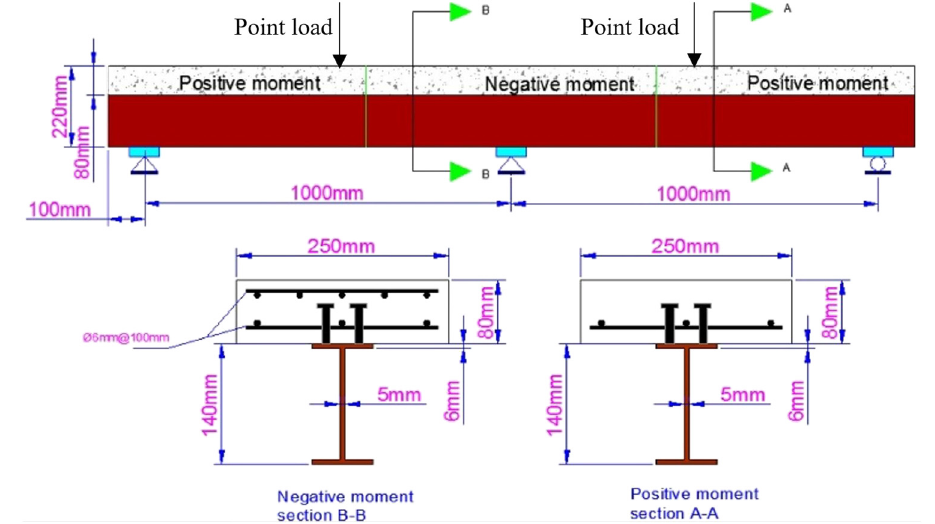
Figure 2: Details of section specimens.